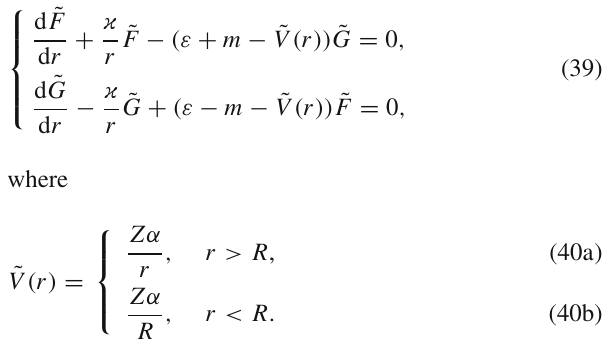
Fig. 3 The dependence of the ground state energy on Z . The square markers are for the exact values of the energy (see (27)) and the round markers are for the approximate ones calculated with the help of (34). The correspondence between color and Z is shown in the legend (the real part of the energy is monotonically decreasing). At Z = Z cr the bound states become resonances with positive Im [ ε ]